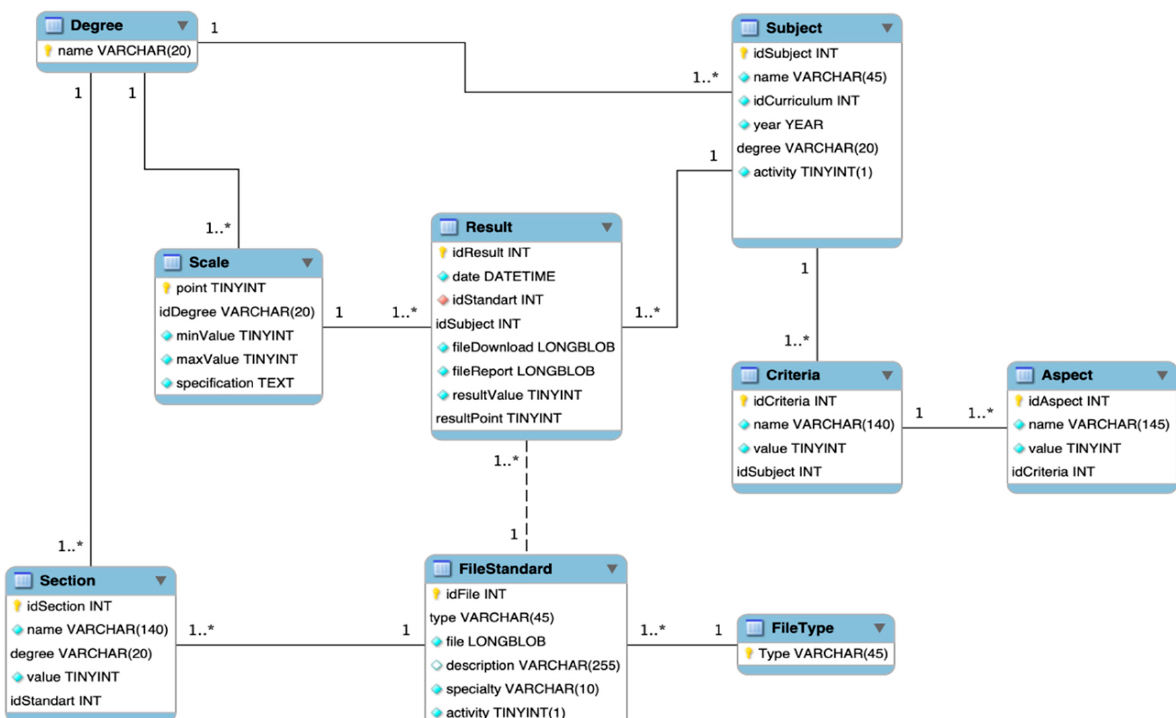
Figure 4. The example of a diagram obtained as a result of aspect assessment.